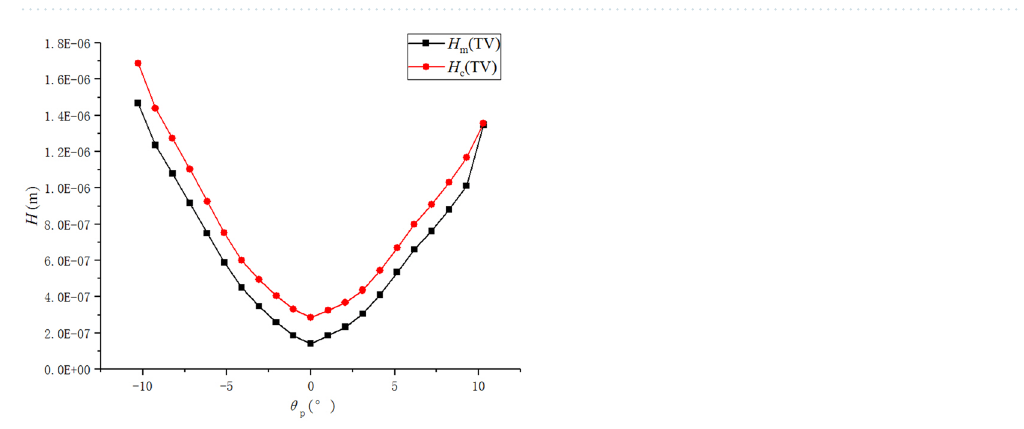
Figure 6. Oil film thickness at each mesh point calculated by the point contact numerical